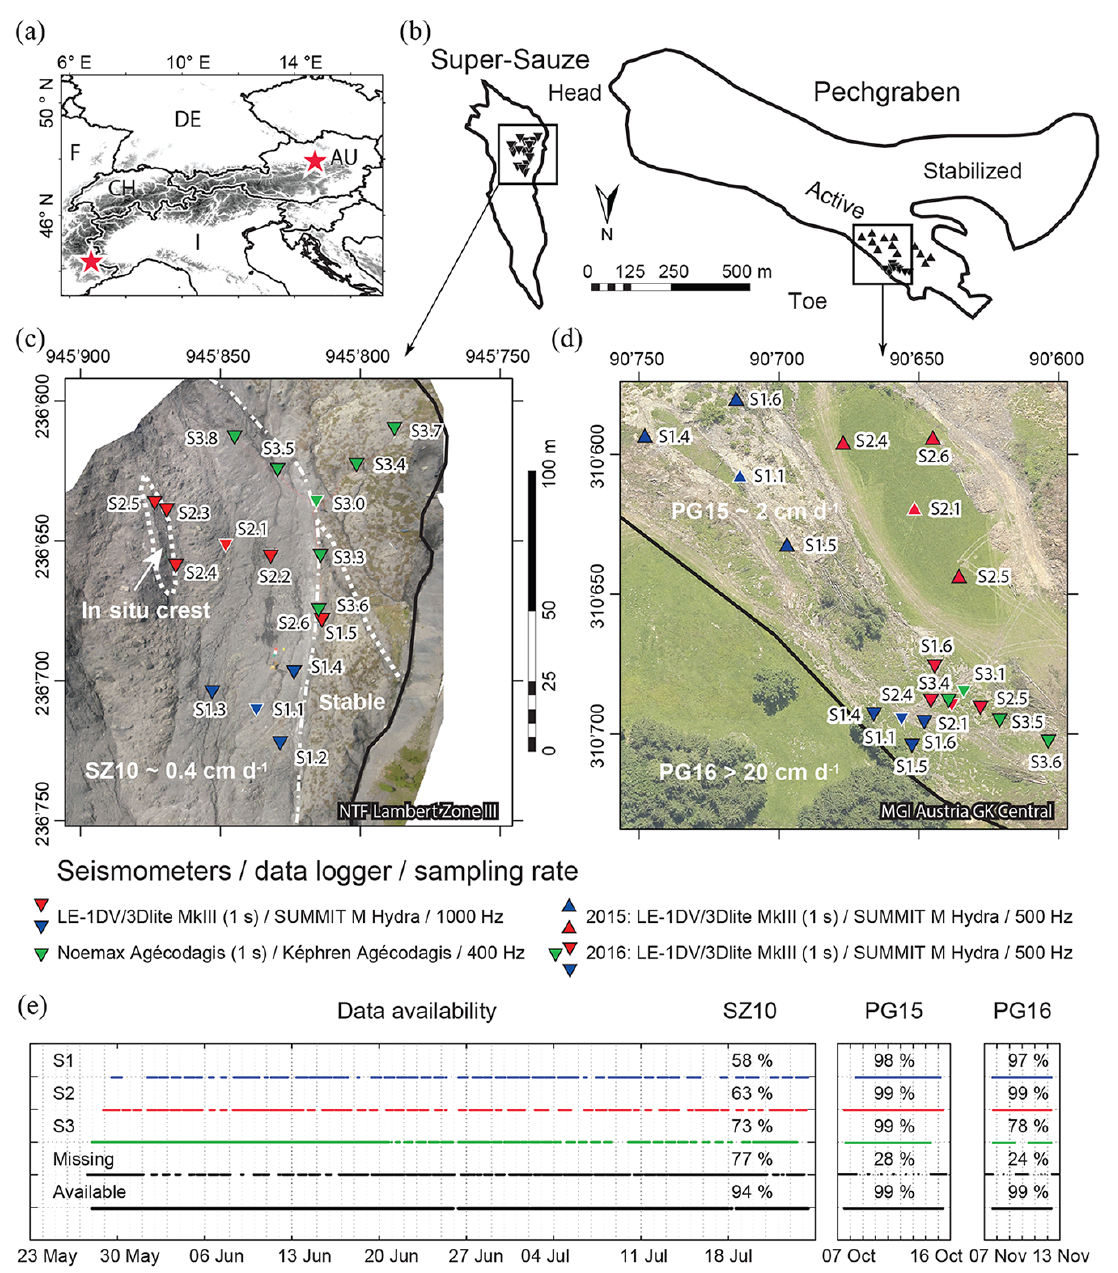
Figure 1. Data overview. (a) Location of Super-Sauze (southeastern France) and Pechgraben (Upper Austria) clayey landslides (stars). (b) Orthogonal projection of Super-Sauze and Pechgraben instabilities including locations of instrumented areas during the three field cam- paigns SZ10, PG15 and PG16. (c–d) Zoom in of Super-Sauze and Pechgraben seismic networks, where triangles indicate the seismic stations and colors refer to different tripartite arrays (S1, blue; S2, red; and S3, green). The average daily displacement rates prevailing during indi- vidual field campaigns are indicated; white dashed lines indicate main subparts of the landslide and black bold lines show the limits of the landslides. 3-C seismometers (S1.1, S2.1, S3.0 and S3.1) are highlighted by white outlines. Orthophotos credits: Super-Sauze, Rothmund et al. (2017); Pechgraben, Lindner et al. (2014, 2016). (e) Data record availability for individual seismic arrays based on 2min data segments. The “missing” line indicates incomplete records (measurements from one or two arrays are missing); the “available” line shows where at least one array is